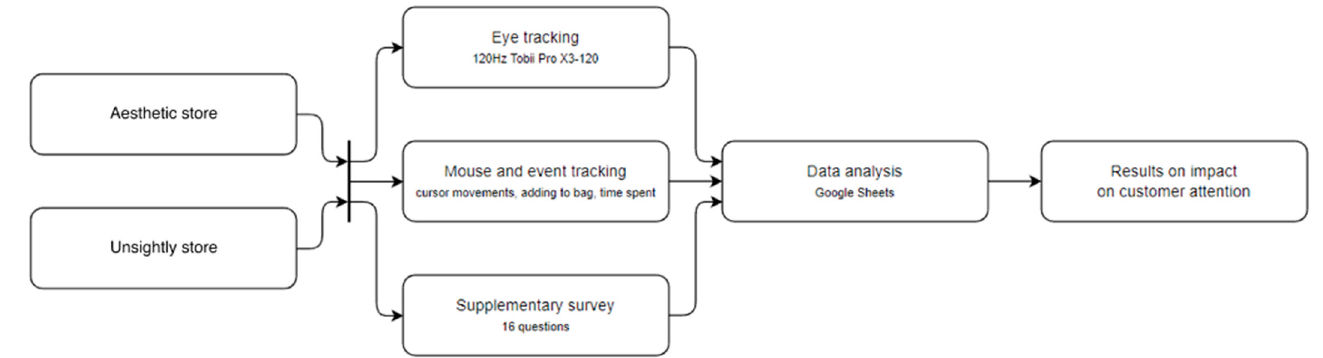
Figure 1. Experimental research procedure. The far left-hand column represents two experimental conditions, the column second from the left represents data acquisition methods, the third column shows the data analysis module, and the far-right column indicates the inferred results module.